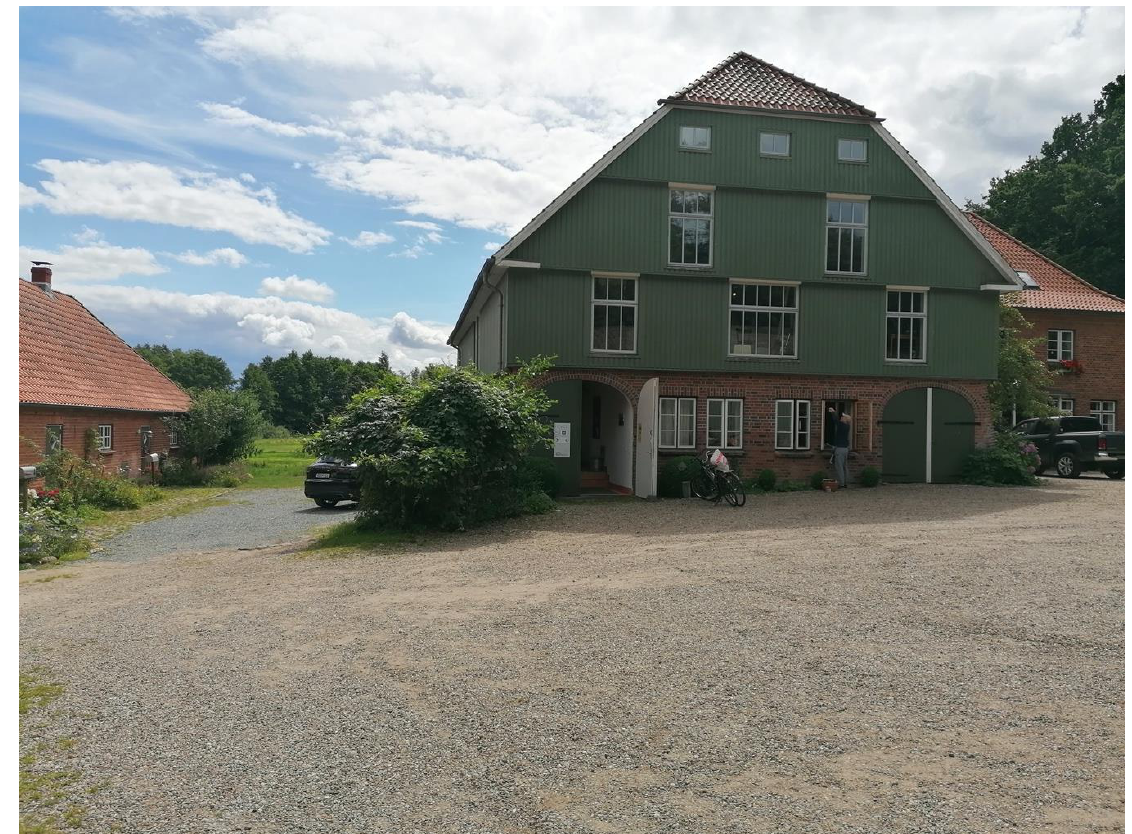
Figure 7. Coworking space in a village, former hayloft, exterior view.